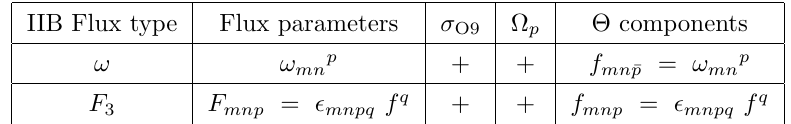
Table 22 . The explicit dictionary between type IIB (cid:13)uxes consistent with the O9 involution and deformation parameters of N = (1 ; 1) supergravity in six